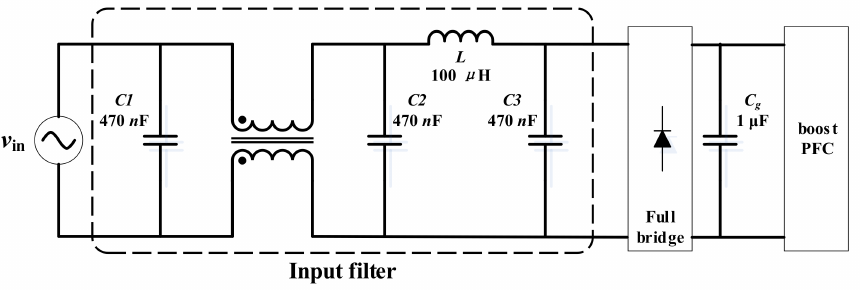
Figure A1. The schematic of input LC